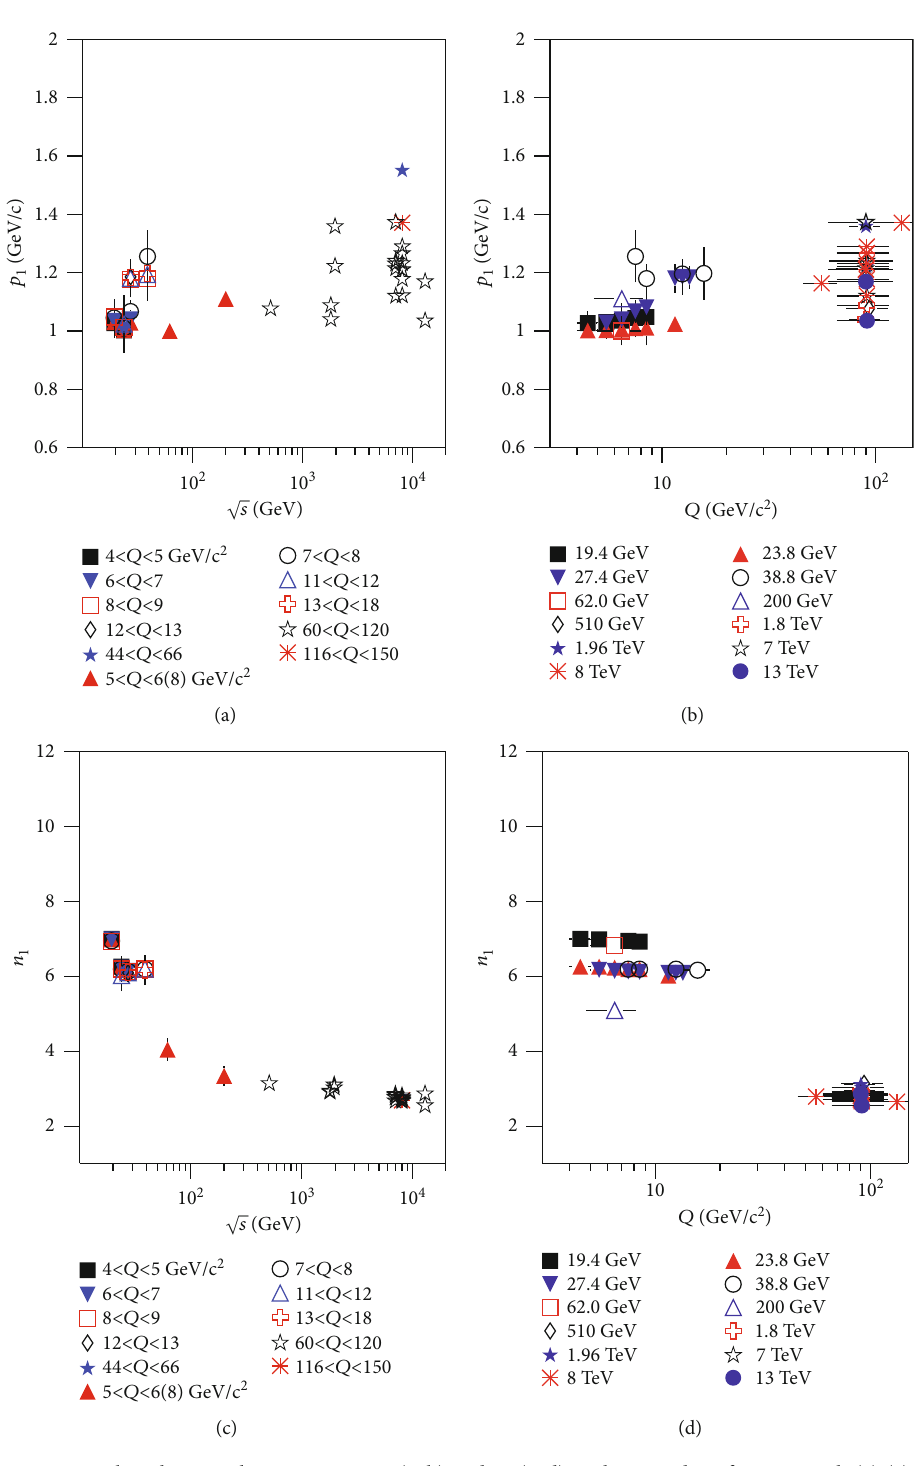
Figure 7: Similar to Figure 5, but showing the parameters p